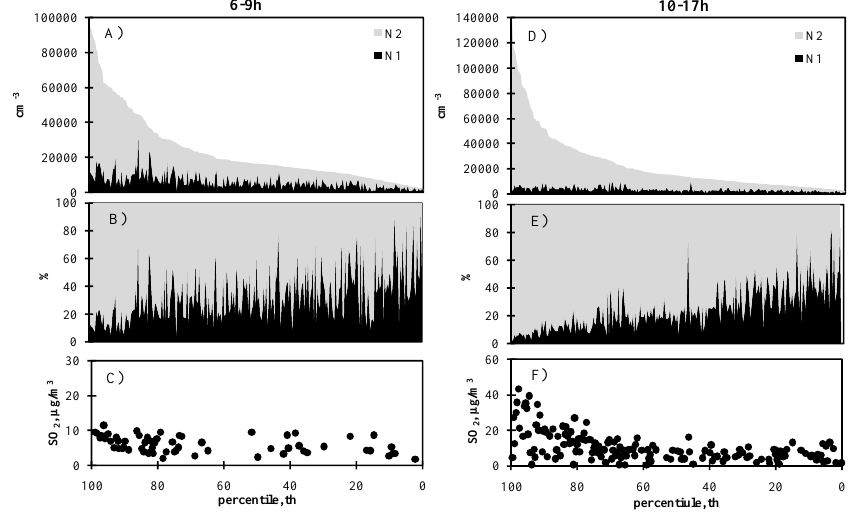
Fig. 10. Hourly average values of total number concentration (N=N1+N2) classified from the highest (100th) to the lowest (0th) value. The contributions of N1 (black) and N2 (grey) to N, in absolute (cm − 3 ; A and D ) and relative (%; B and E ) concentrations, are highlighted. The SO 2 concentrations associated with the decreasing N values (from 100th to 0th) are plotted ( C and F